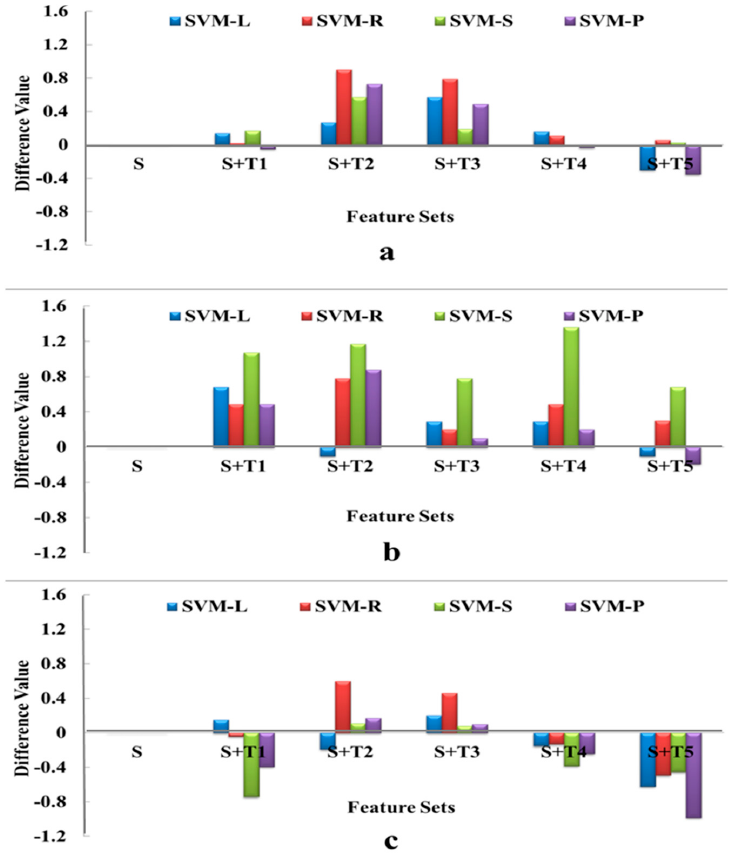
Figure 5. The accuracy changes of different kernel functions SVM using different feature sets: ( a ) the difference value of overall accuracy; ( b ) the difference value of producer accuracy; and ( c ) the difference value of user accuracy; Difference Value = Accuracy (S + T1/S + T2/S + T3/S + T4/S + T5) − Accuracy S ).